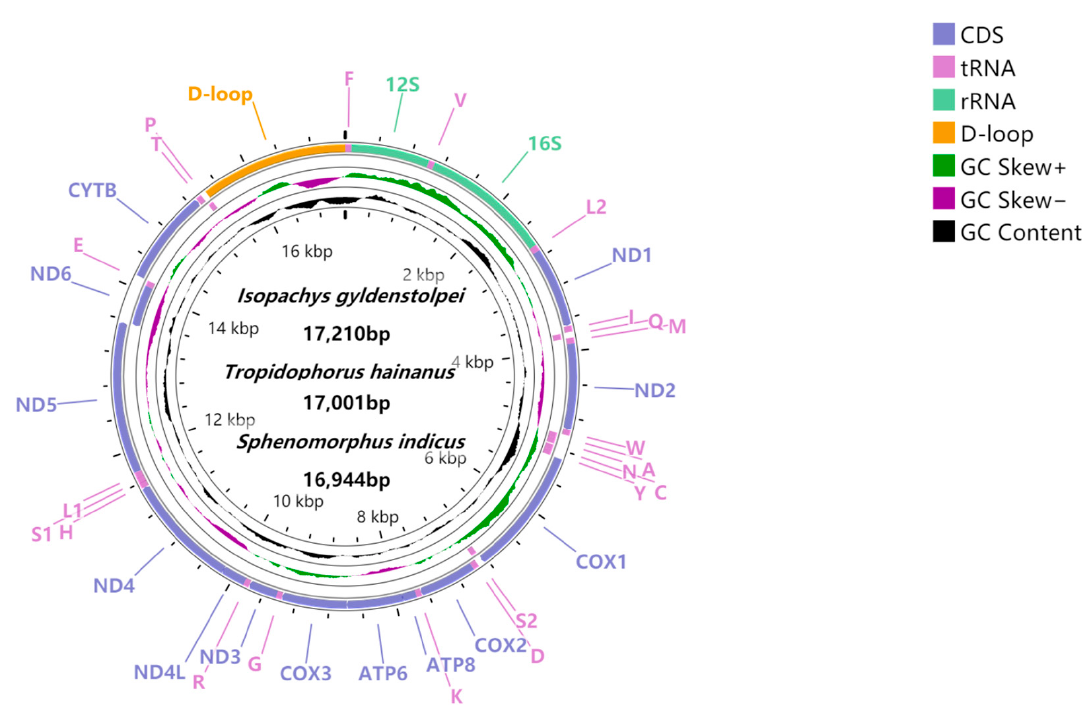
Figure 1. Circular visualization maps of the complete mitochondrial genomes of I . gyldenstolpei , T . hainanus , and S . indicus (since the mitochondrial genomes of the three skinks are similar in structure, a map was used to represent the three skinks). The three circles from the outside to the inside show the gene map (PCGs, rRNAs, tRNAs, and the AT-rich region), the GC content, and GC skew, respectively. Among them, the genes outside the map are coded on the majority strand (J-strand), whereas the genes inside the map are coded on the minority strand (N-strand). Table 2. Base composition of the mitochondrial genomes of the three skinks.